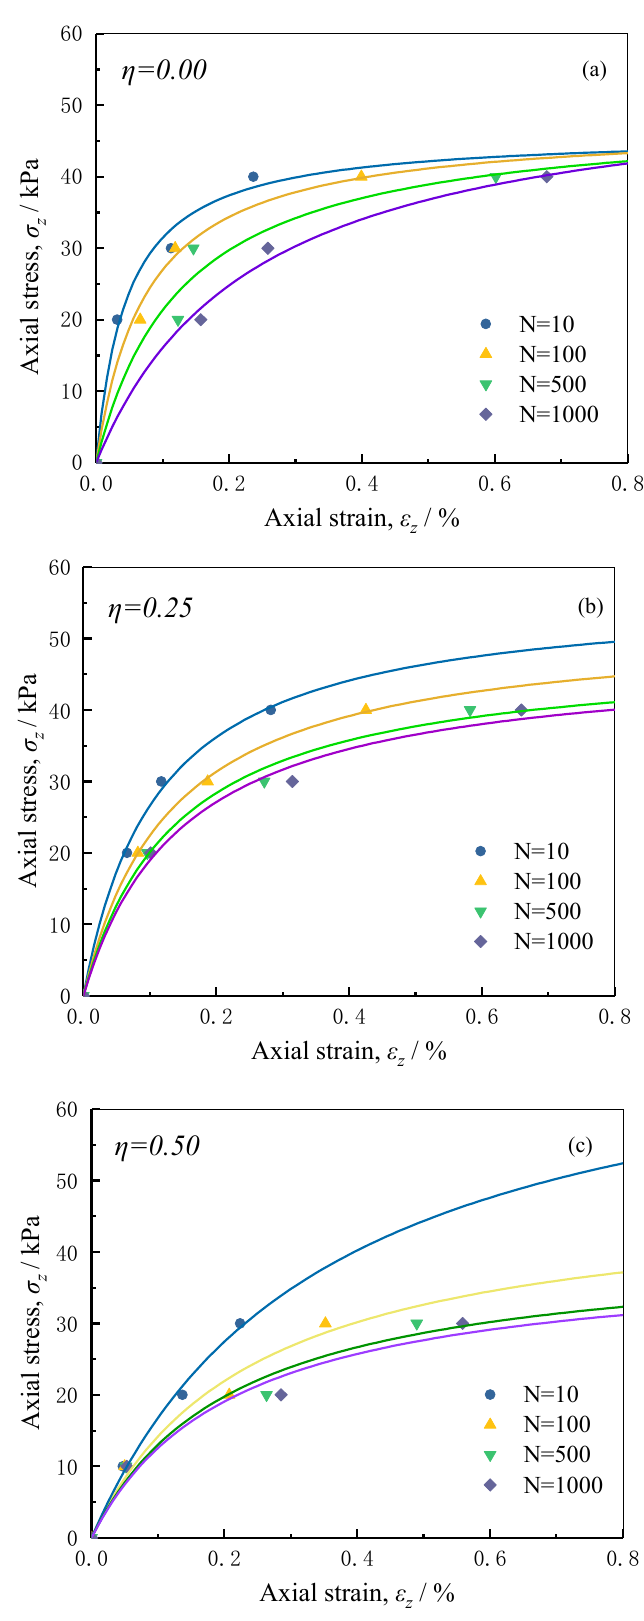
Figure 13. Backbone curves with different η under different cycles: ( a ) η = 0.00; ( b ) η = 0.25; ( c ) η = 0.50.